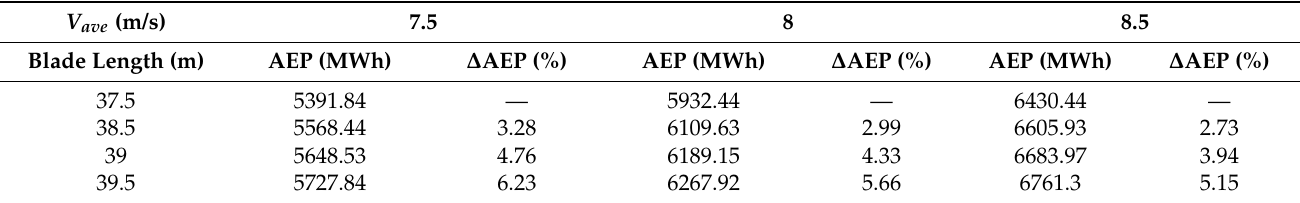
Table 4. Annual energy production of turbines with different blade Figure 6. Steady power curves of turbines with different blade lengths.